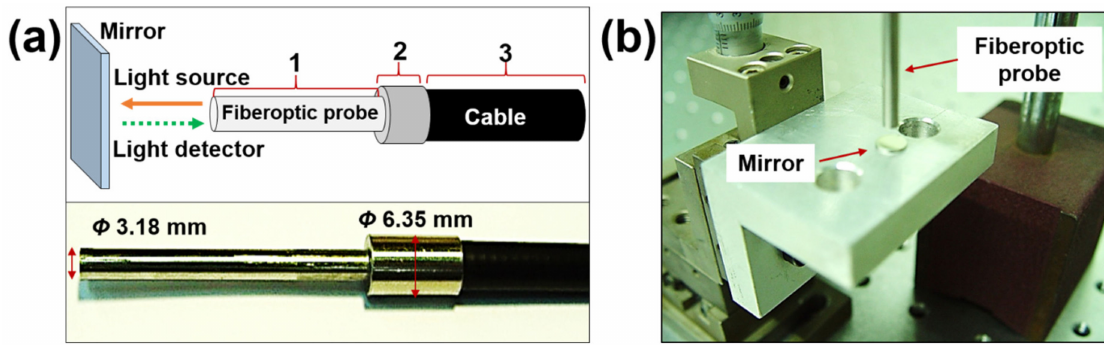
Figure 1. Principle of the distance measurement of the fiberoptic sensor: ( a ) schematic design and photo; ( b ) setup used for the calibration of the sensing distance